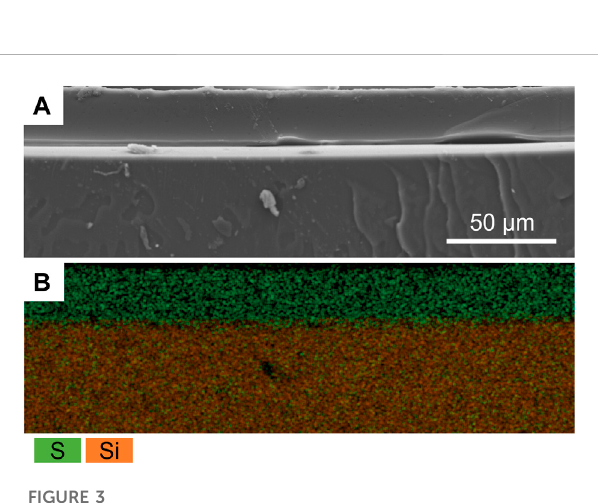
FIGURE 3 (A) Scanning electron microscopy image of the P(SBMA) coating (20% SBMA, 20:1 ratio SBMA to BIS) cross-section and (B) its energy- dispersiveX-ray spectroscopy mapofsulfur (green)and silica(orange) overlay representing P(SBMA) coating and PDMS support, respectively.